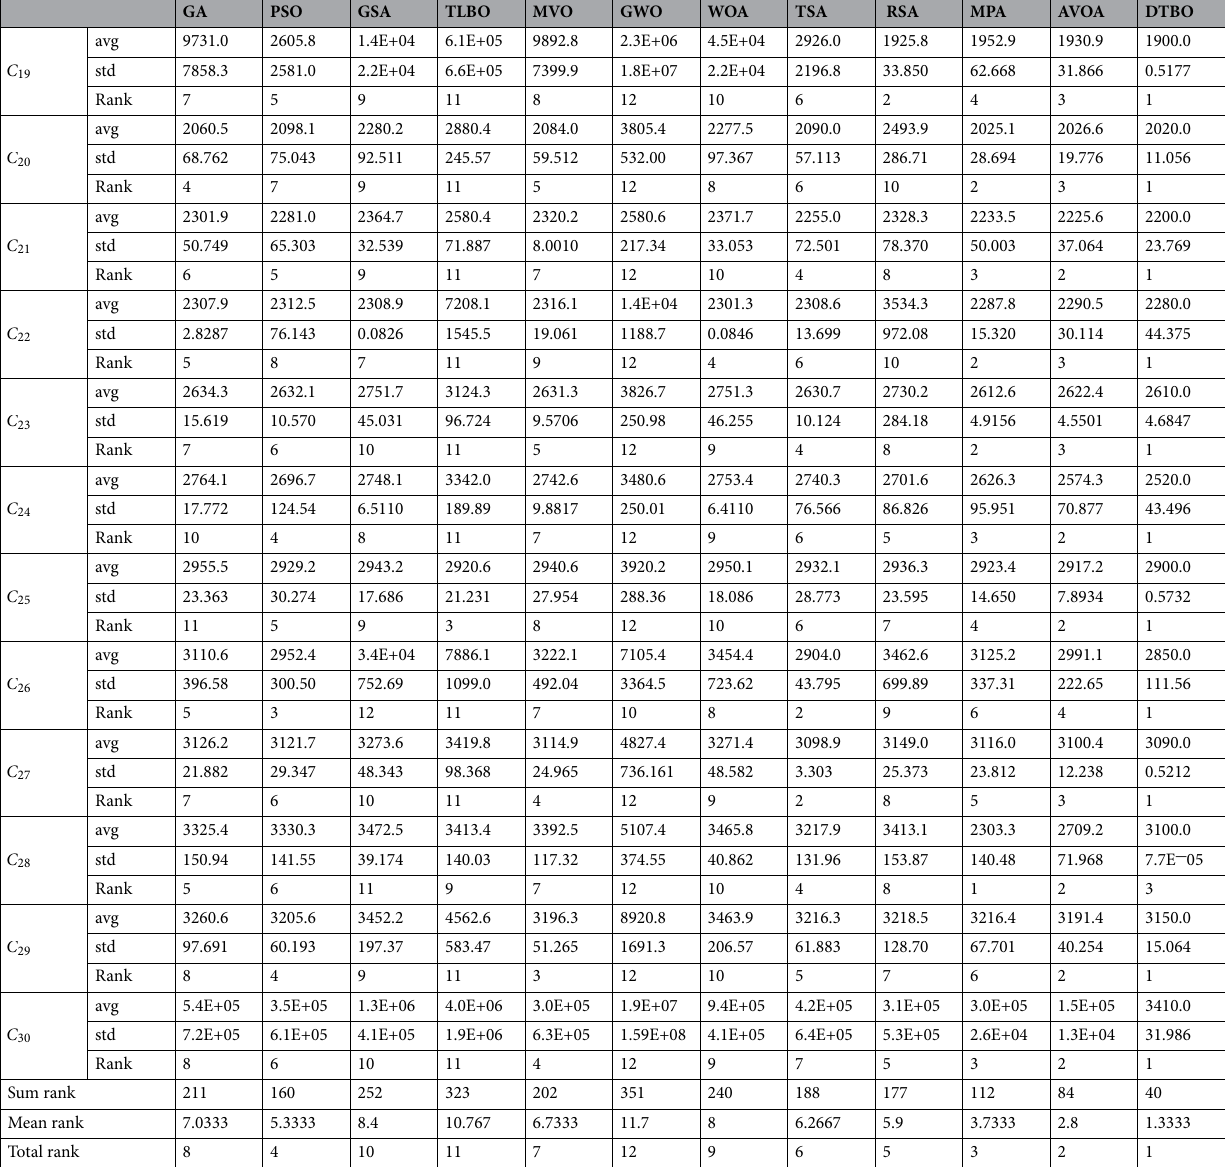
Table 6. Evaluation results of the IEEE CEC 2017 objective functions C 19 to C 30